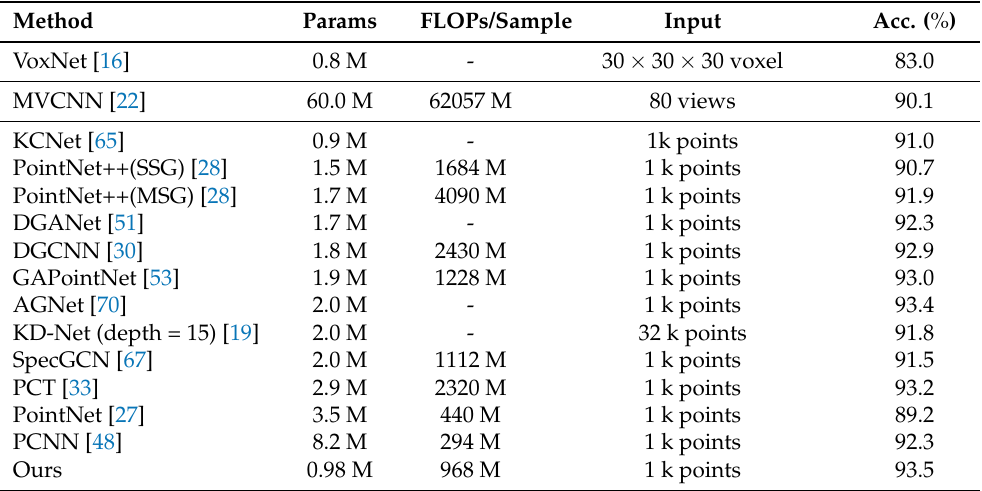
Table 4. Complexity of the model for ModelNet40 classification (res: resolution; k: 1024; M: million). The three parts from top to bottom are voxel-based, view-based and point-based methods.